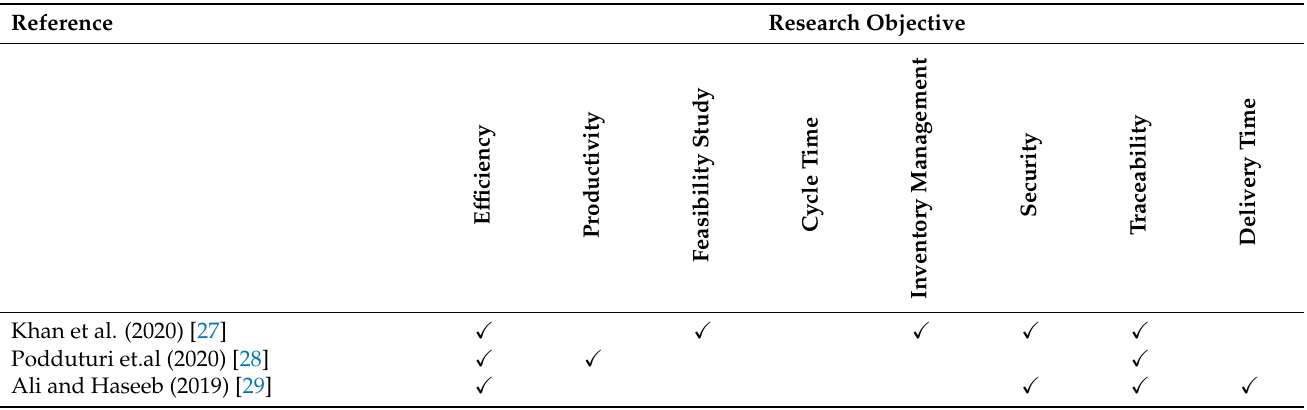
Table 2. Literature classification regarding the research objectives based on